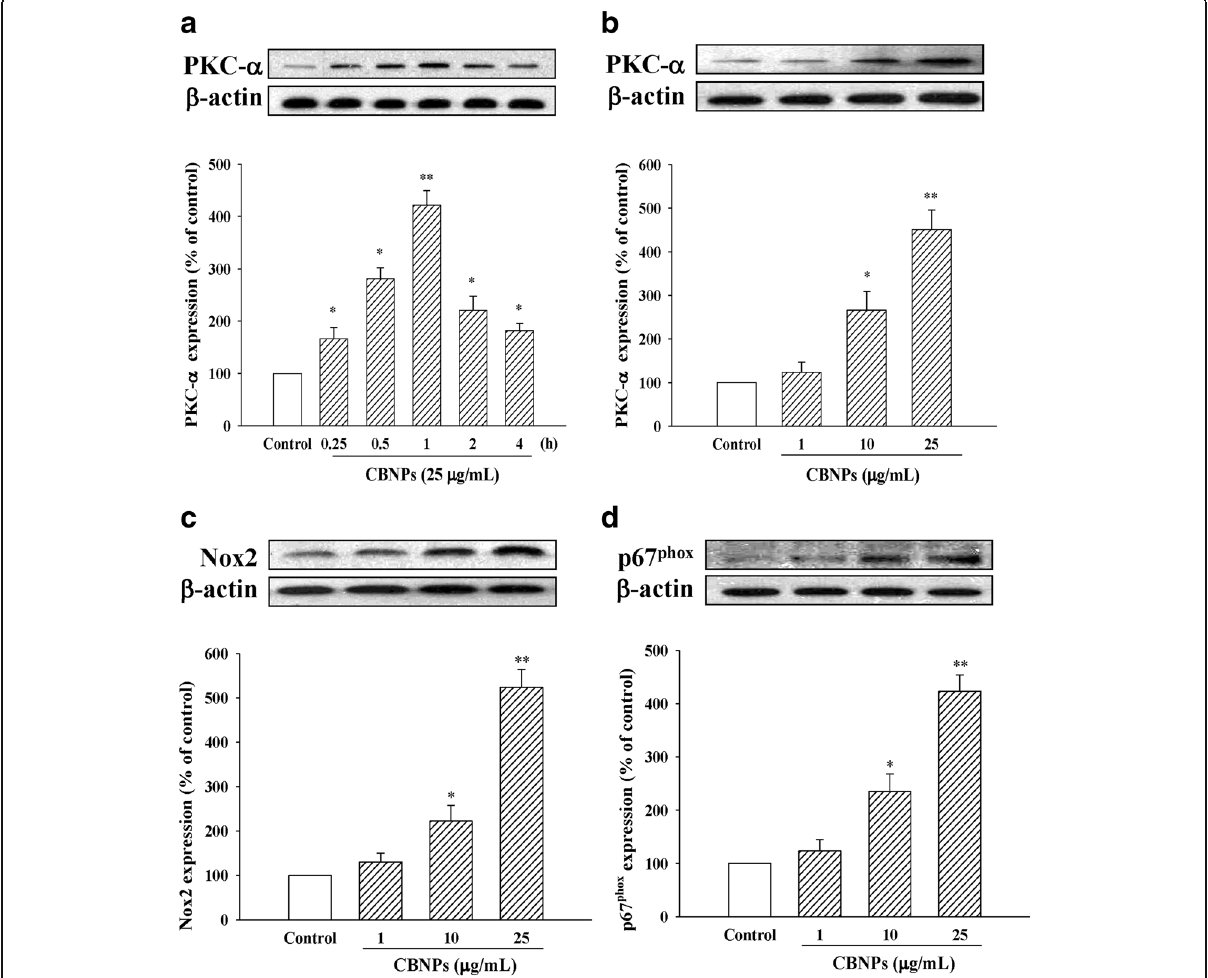
Fig. 2 Effects of CBNPs (25 μ g/mL) on PKC- α expression after 0.25 to 4 h of CBNPs treatment in A549 cells ( a ). Effects of CBNPs (1 – 25 μ g/mL) on PKC- α expression after 1 h of CBNPs treatment in A549 cells ( b ). Effects of CBNPs on protein expression of Nox2 ( c ), membrane protein expression of p67 phox ( d ). c-d Cells were treated with CBNPs (1, 10, 25 μ g/mL) for 24 h. Bars represent the mean ± S.E.M. from six independent experiments. * P < 0.05, ** P < 0.01 vs. control group (without any